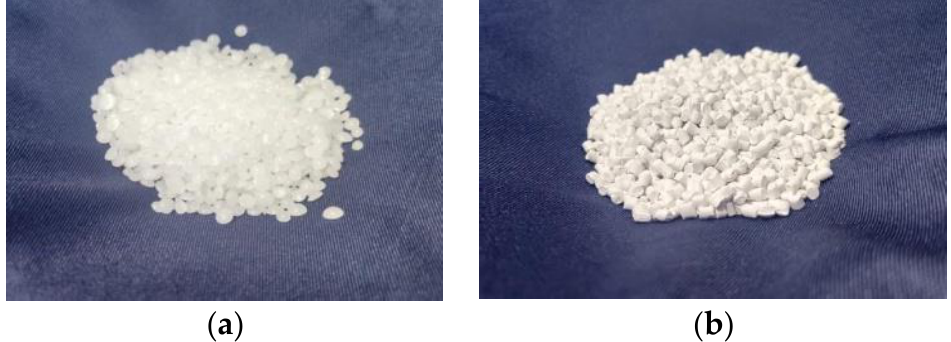
Figure 1. Appearances of recycled PE pellets and PP pellets. ( a ) PE pellets ( b ) PP pellets. Table 2. Basic indicators of recycled PE pellets.